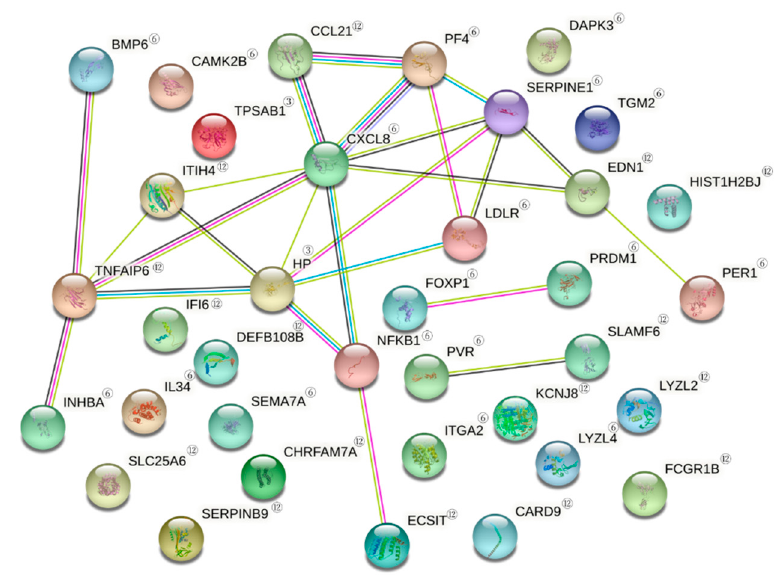
Figure 1. PPI of upregulated DEGs. Search tool STRING analysis of interacting genes and proteins reveals a protein–protein interaction PPI network in defense response by LLLT. PPI of upregulated DEGs related to ‘defense response’ Related genes after the irradiation at 3 h; ③ , 6 h; ⑥ 12 h; ⑫ Red line: indicates the presence of fusion evidence; green line: neighborhood evidence; blue line: cooccurrence evidence; purple line: experimental evidence; yellow line: text mining evidence; light blue line: database evidence; black line: coexpression evidence.